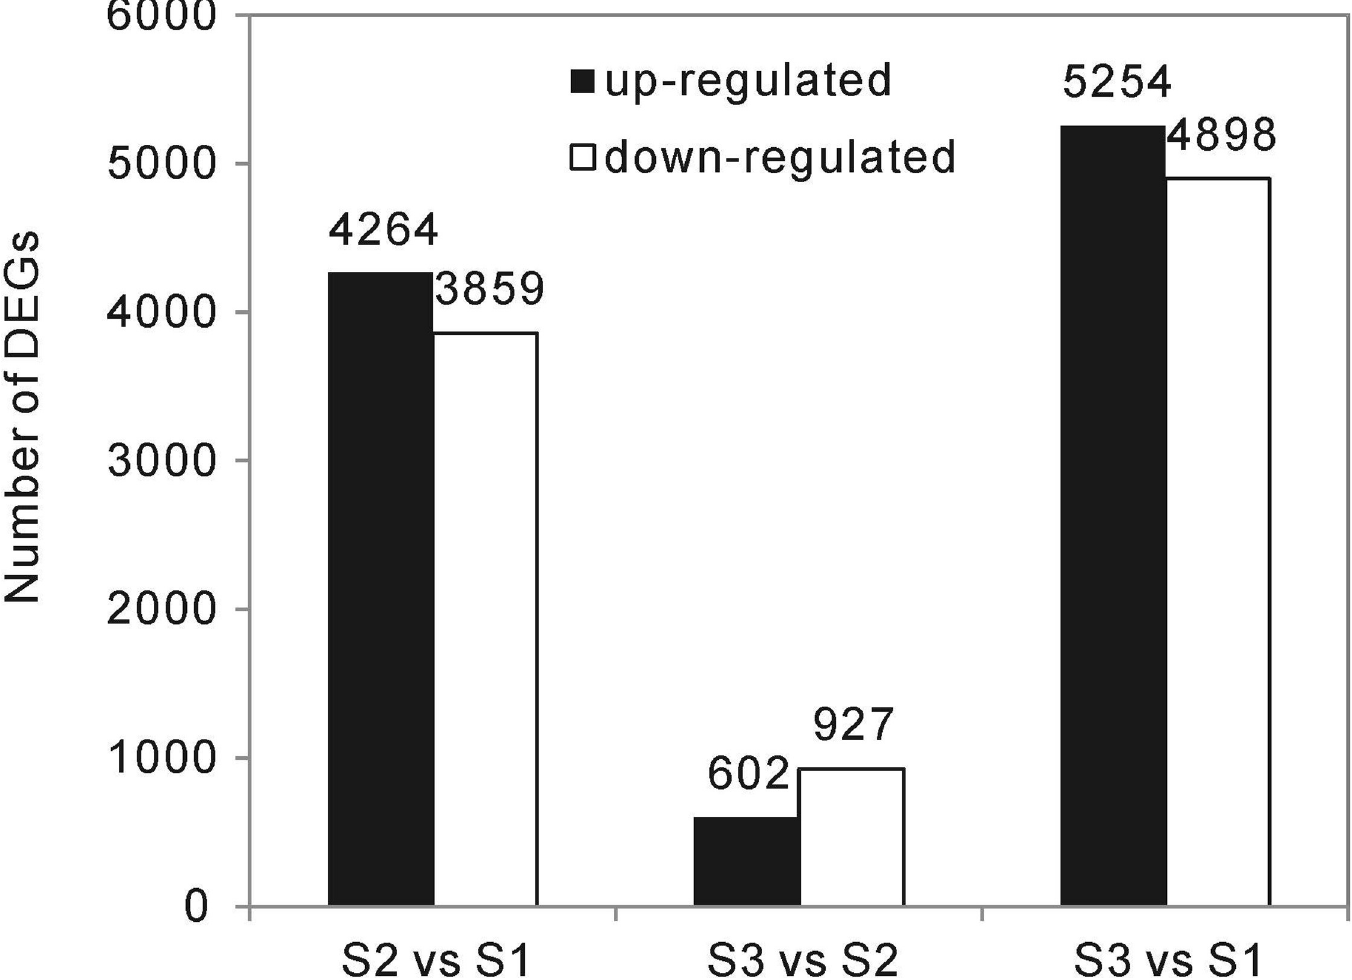
Fig 3. Number of DEGs between the different ripeness stages. Only transcripts exhibiting a fold change > 2 in at least one of the ripeness stage of the L . ruthenicum fruits were